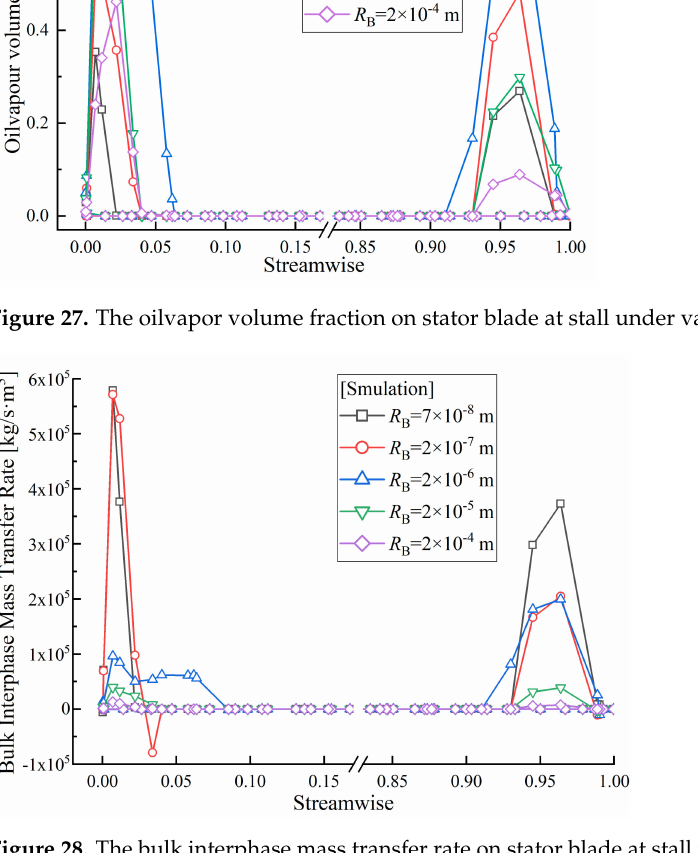
Figure 28. The bulk interphase mass transfer rate on stator blade at stall under various mean radius.